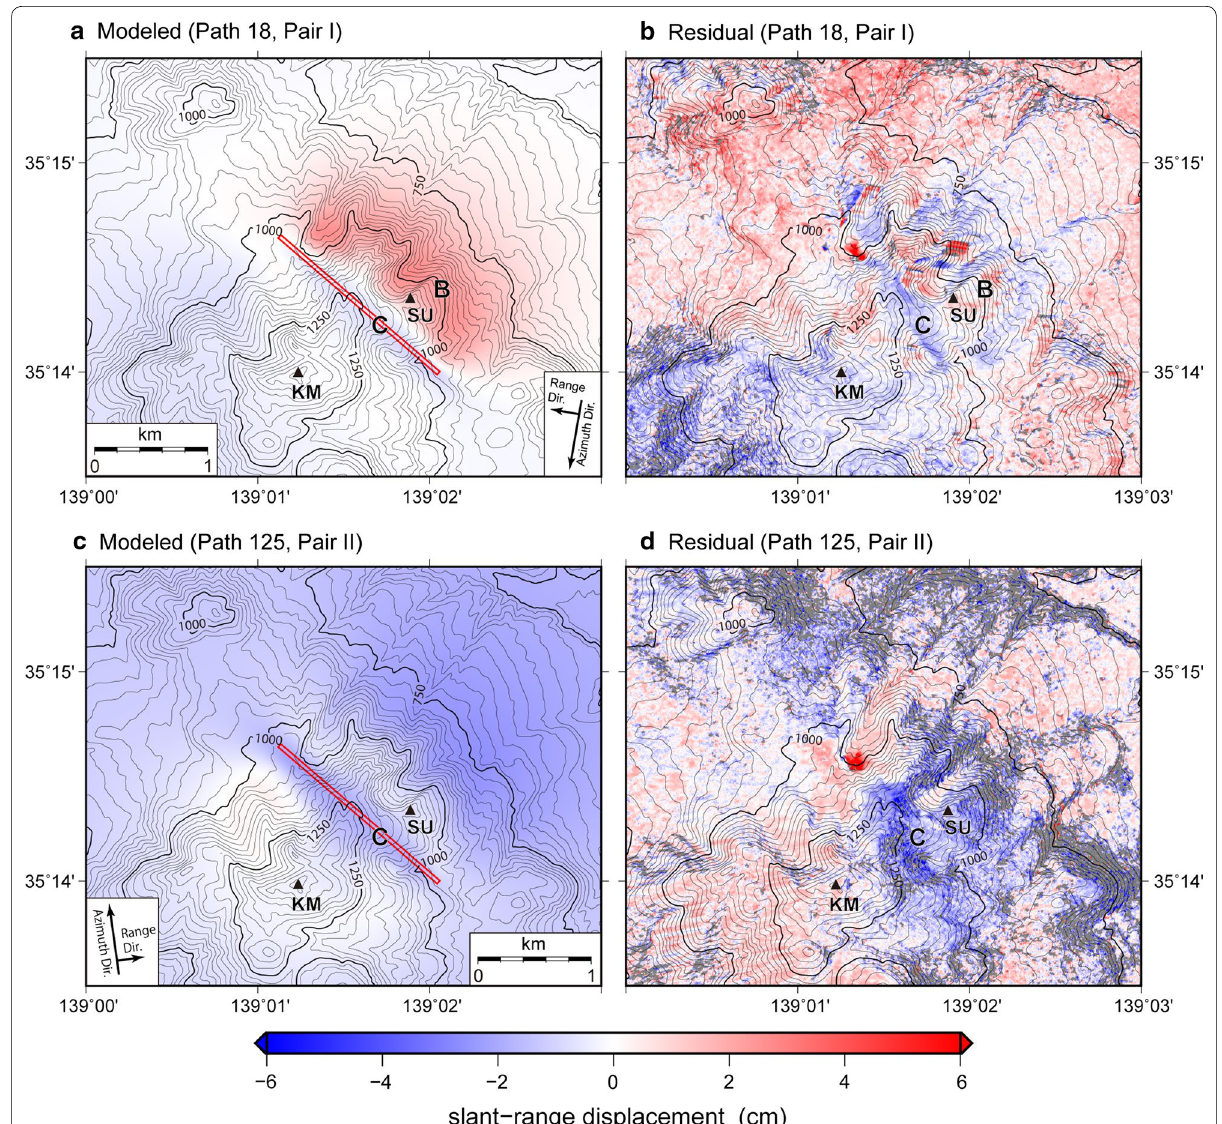
Fig. 6 Result of the single open crack model inversion. a Modeled surface displacements, and b residuals between model and observation for Pair I. c Modeled surface displacements, and d residuals between model and observation for Pair II. B and C indicate displacement areas mentioned in the text. KM and SU show the summits of Kamiyama and Sounzan, respectively. Offset parameters were 2.78 mm for Pair I and –13.70 mm for Pair II. The red rectangle shows the estimated open crack, the parameters of which are listed in Table 2. Pair II was not used as an input dataset during the